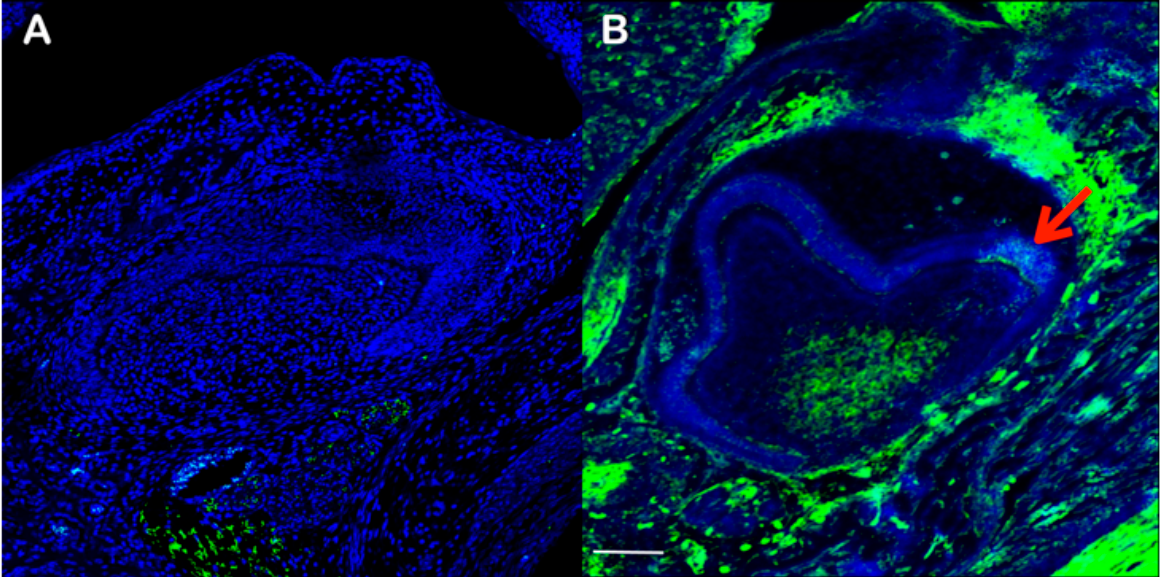
Figure 8. Frontal section showing immunohistochemistry of Cacna1S in wild-type mouse at embry- onic day 17.5 ( B ). Negative control ( A ). Arrow in B indicates Cacna1s expression at the secondary enamel knot. Scale bar: 100 µm.